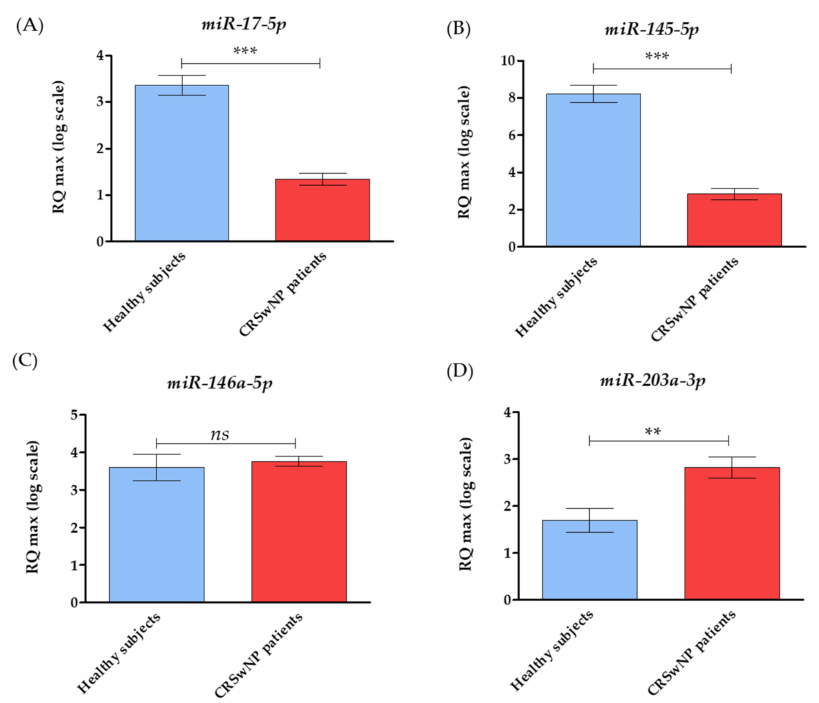
Figure 3. The miRNA levels were associated with apoptosis and cell survival. Transcript levels were established for CRSwNP patients and compared to levels determined in healthy subjects. The following miRNAs were measured: miR-17-5p ( A ); miR-145-5p ( B ); miR-146a-5p ( C ), and miR-203a- 3p ( D ); the average fold change of the target genes was determined in relation to the housekeeping gene, i.e., small nuclear RNA U6 (snU6). Statistically, significant differences are indicated with an asterisk. Statistically significant differences were noted at p < 0.01 (**), and p < 0.001 (***).